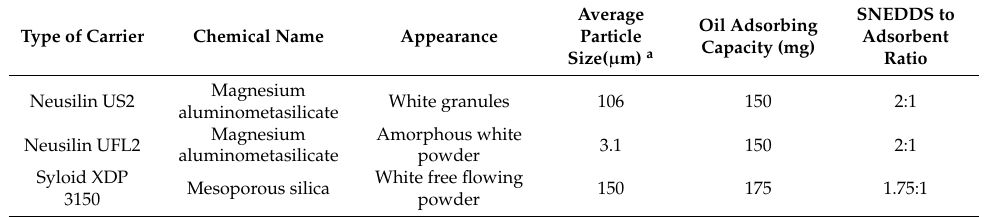
Table 5. Oil adsorption capacity of porous carriers studied for the preparation of DFX- Solid-SNEDDS (S-SNEDDS).